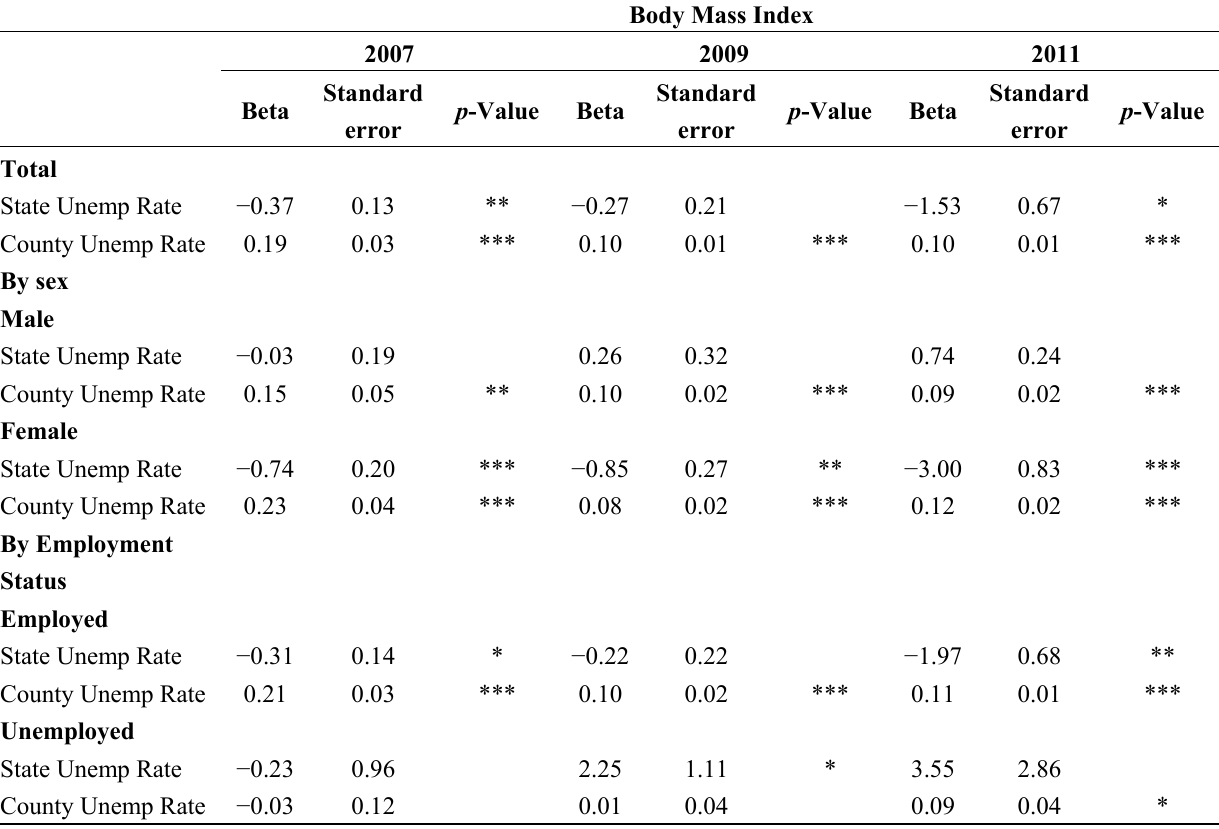
Table 2. Linear relationship between body mass index and state and county unemployment (unemp) rates among BRFSS participants in 2007, 2009 and